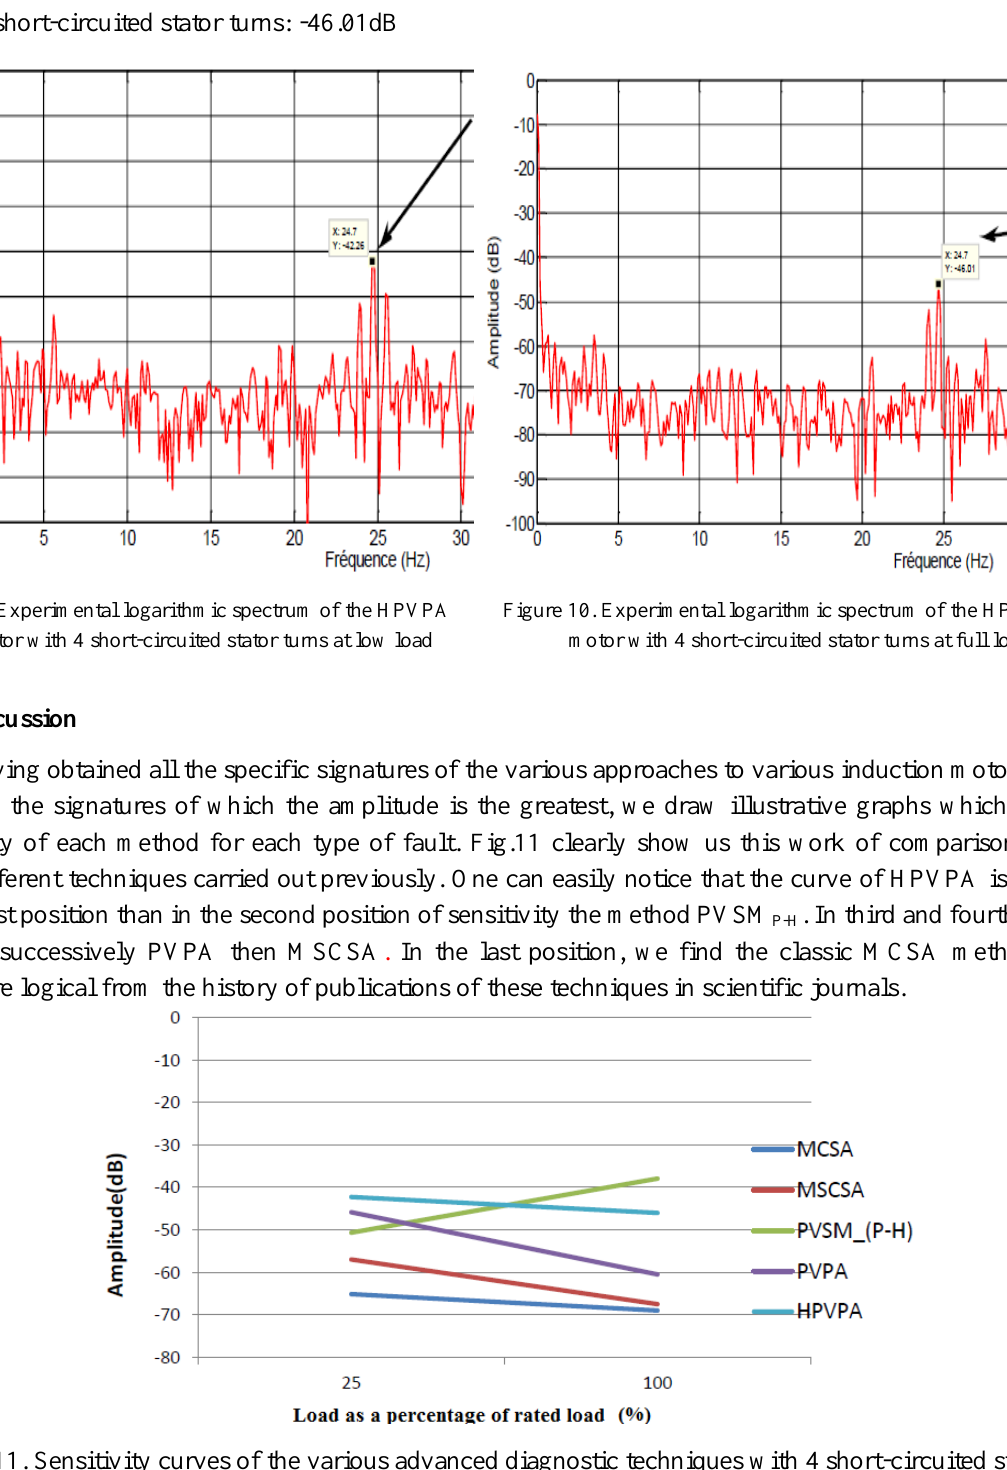
Figure 11. Sensitivity curves of the various advanced diagnostic techniques with 4 short-circuited stator